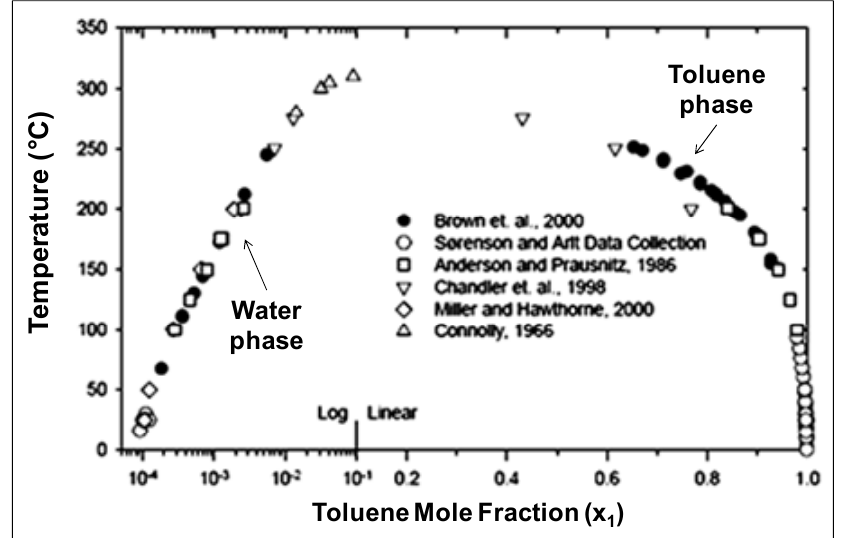
Figure 11. Liquid-liquid equilibria of toluene (component 1) and water (component 2). The data above 100 °C were reported at the saturation pressure